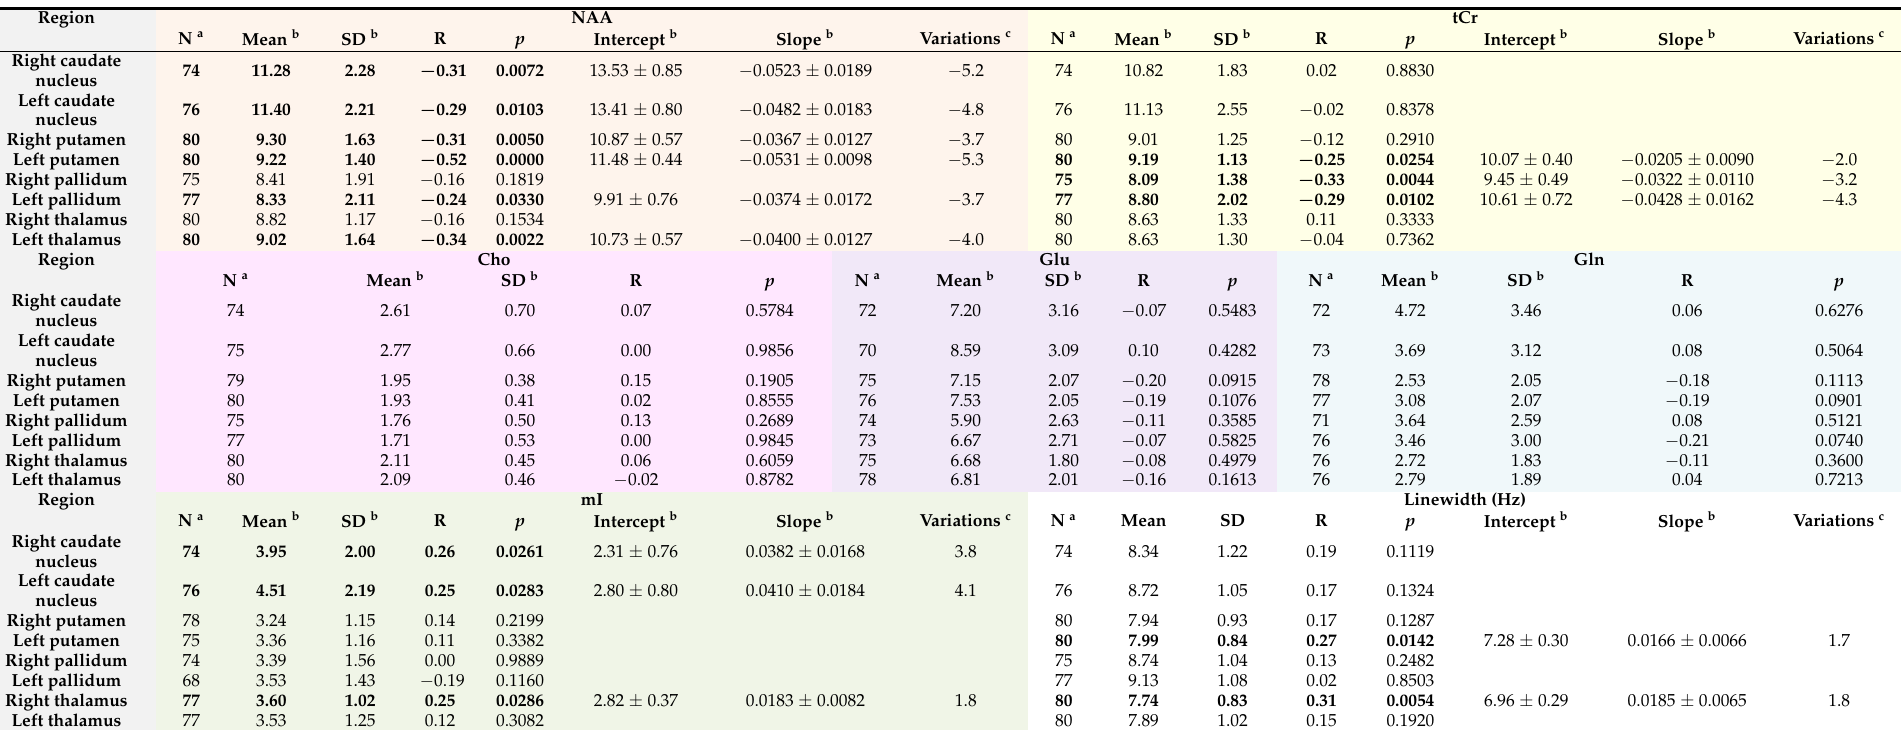
Table 1. The mean values and the age associations of the regional metabolite concentrations and the spectral linewidths estimated with linear regression